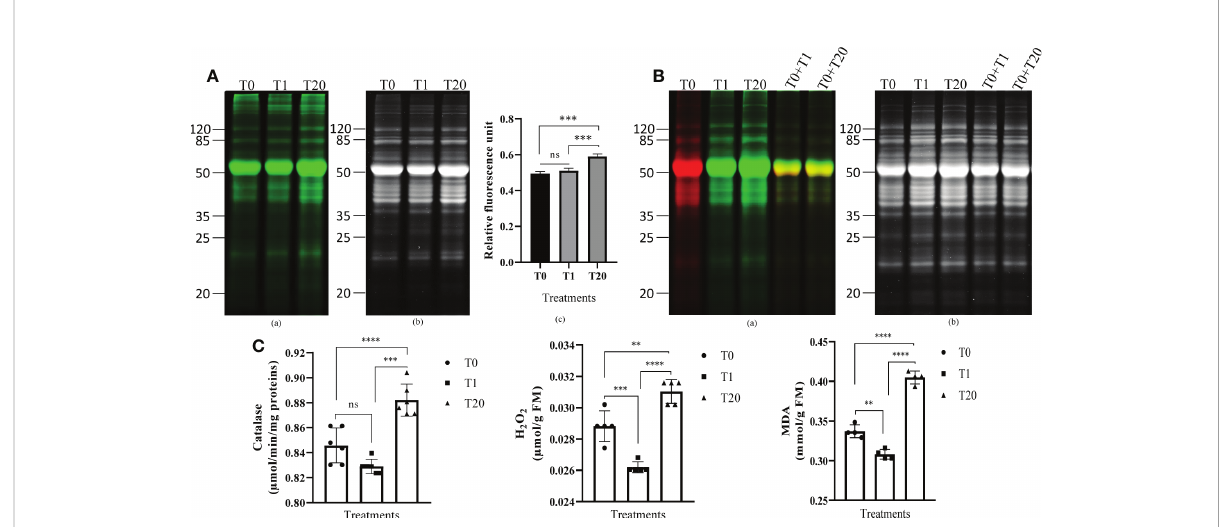
FIGURE 1 Exogenous H 2 O 2 modulates protein carbonylation in A. thaliana plant leaves. (A) Representative gel pictures for carbonylated proteins (a) and the total proteins stained with AzureRed (b) are shown. A total of 10 µg of proteins labeled with the carbonyl-reactive probes Cy7.5-Hz probe was loaded in each lane. T0: control, distilled water; T1: H 2 O 2 at 1 mM; T20: H 2 O 2 at 20 mM. The bar plot (c) represents relative fl uorescence intensity of carbonylated proteins measured from the gel picture (a) by using the Azure biosystems software. Results are from at least three independent experiments and represent means ± SEM (n=3). Asterisks denote statistical signi fi cance at p < 0.001, one-way ANOVA, Tukey post hoc test. ns: not signi fi cant. (B) Two probes-based gel comparison of carbonylated protein pro fi les. Representative gel pictures for the carbonylated proteins (a) and the total proteins stained with AzureRed (b) are shown. T0: control, distilled water; T1: H 2 O 2 at 1 mM; T20: H 2 O 2 at 20 mM. Carbonylated proteins in the control sample were labeled with Cy5.5-Hz probe, and those in the H 2 O 2 -treated plant samples were labeled with Cy7.5-Hz probe. Lanes T0 +T1, and T0+T20 combine each equal amount (5 µg) of the Cy5.5-Hz-labeled control and Cy7.5-Hz-labeled H 2 O 2 -treated samples. (C) Catalase enzyme activity (a) , H 2 O 2 level (b) , and MDA (c) in leaves of 21 days-old seedlings. Results are from at least three independent experiments and represent means ± SEM (n=3). Two, three, and four asterisks denote statistical signi fi cance at p < 0.01, p < 0.001, and p < 0.0001, respectively; one-way ANOVA, Tukey post hoc test. ns: not signi fi